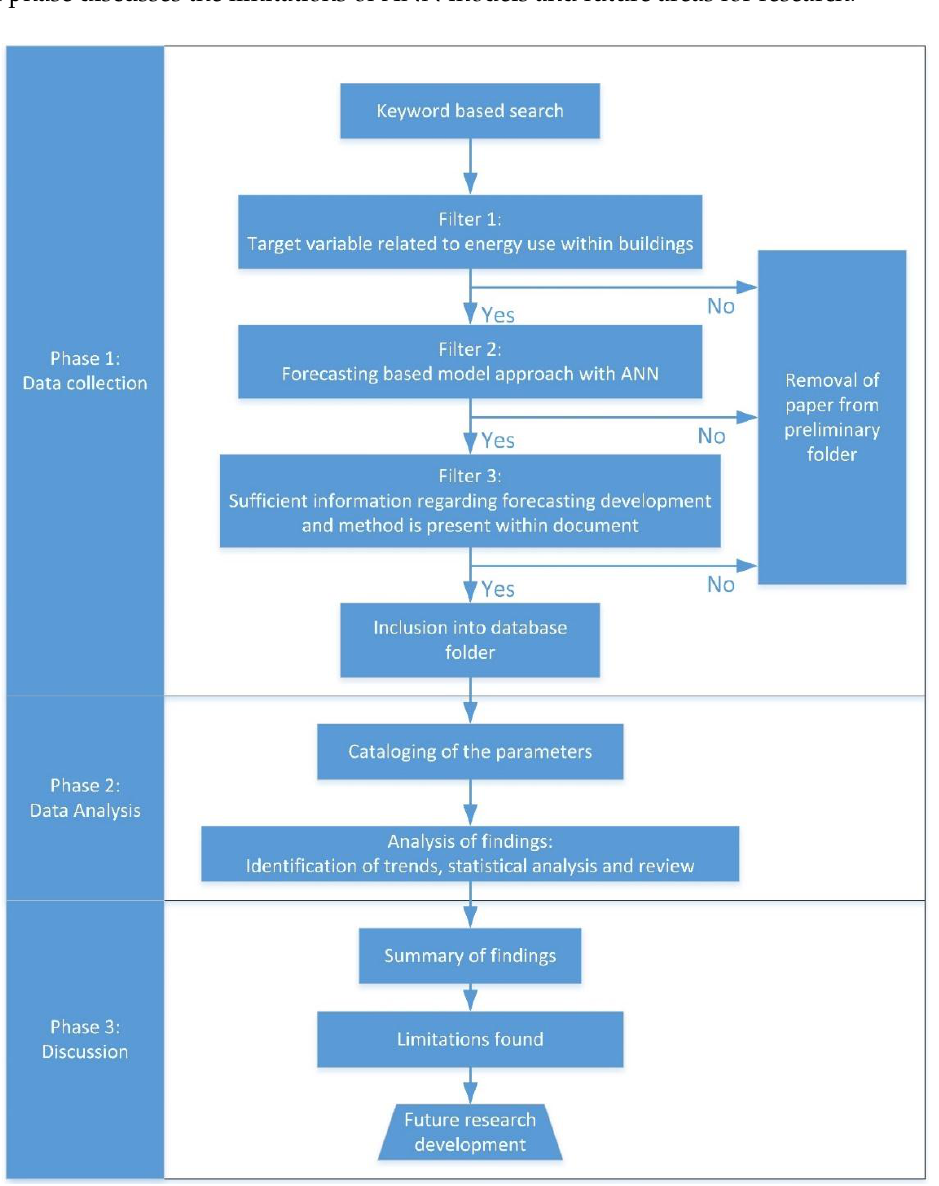
Figure 3. Methodology for the literature review.